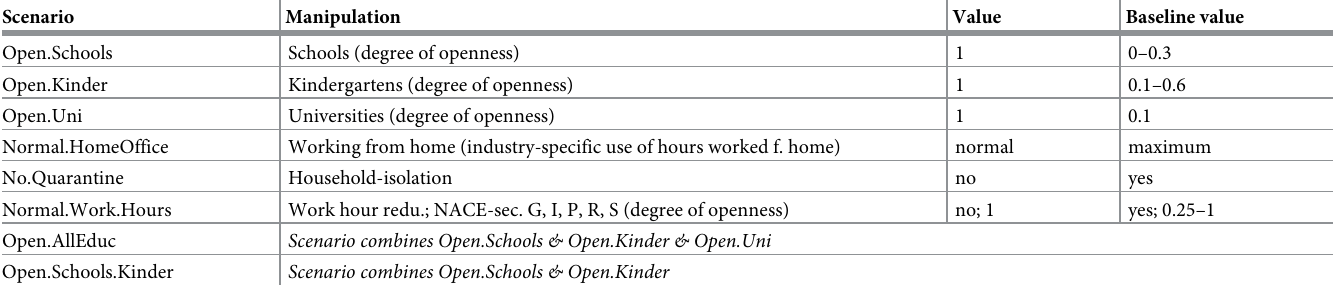
Table 2. Manipulation of NPIs in counter-factual